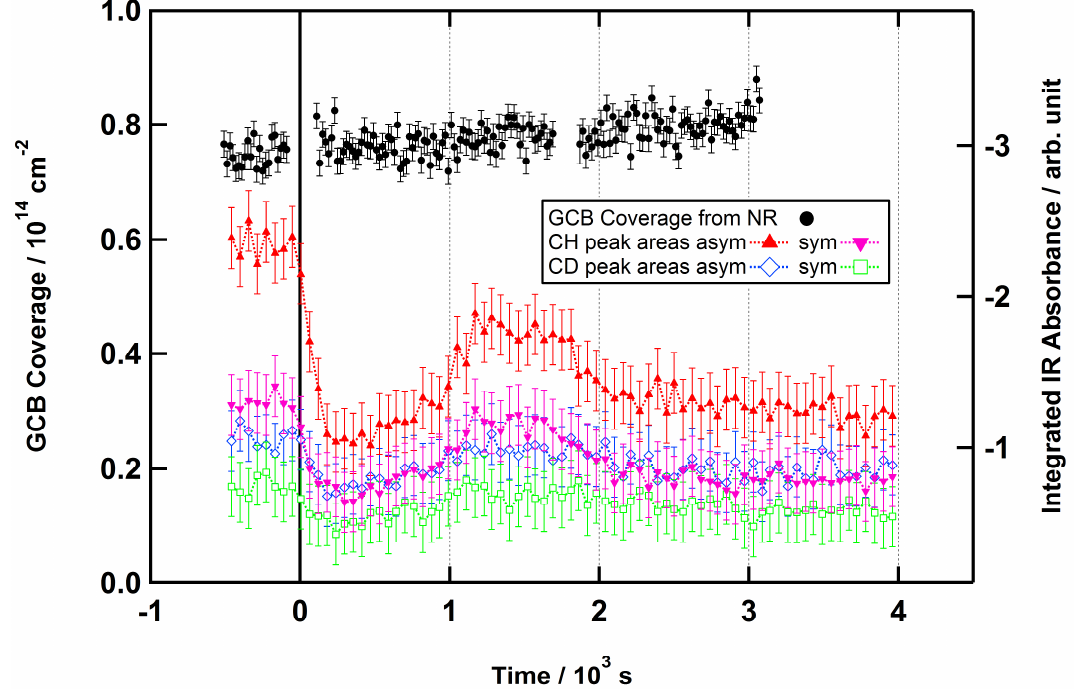
Figure 7. Oxidation of a two component (GCB/PA) monolayer on pure water—NR (black circles and left ordinate) and IRRAS (coloured symbols and right ordinate) data as a function of time. We spread a monolayer of ~6.5 × 10 − 5 L from a spreading solution containing ~0.5 g L − 1 of d -GCB and ~0.5 g L − 1 of d -PA in CHCl 3 . NO 3 • was admitted at t = 0 s at a concentration of ~4.4 × 10 9 cm − 3 . The integrated absorbance areas for the IRRAS data were calculated for 2110–2070 cm − 1 and 2208–2178 cm − 1 for CD bonds (one symmetric and one asymmetric stretch coloured squares and diamonds) and for 2868–2833 cm − 1 and 2945–2898 cm − 1 for CH bonds (one symmetric and one asymmetric stretch; coloured triangles).